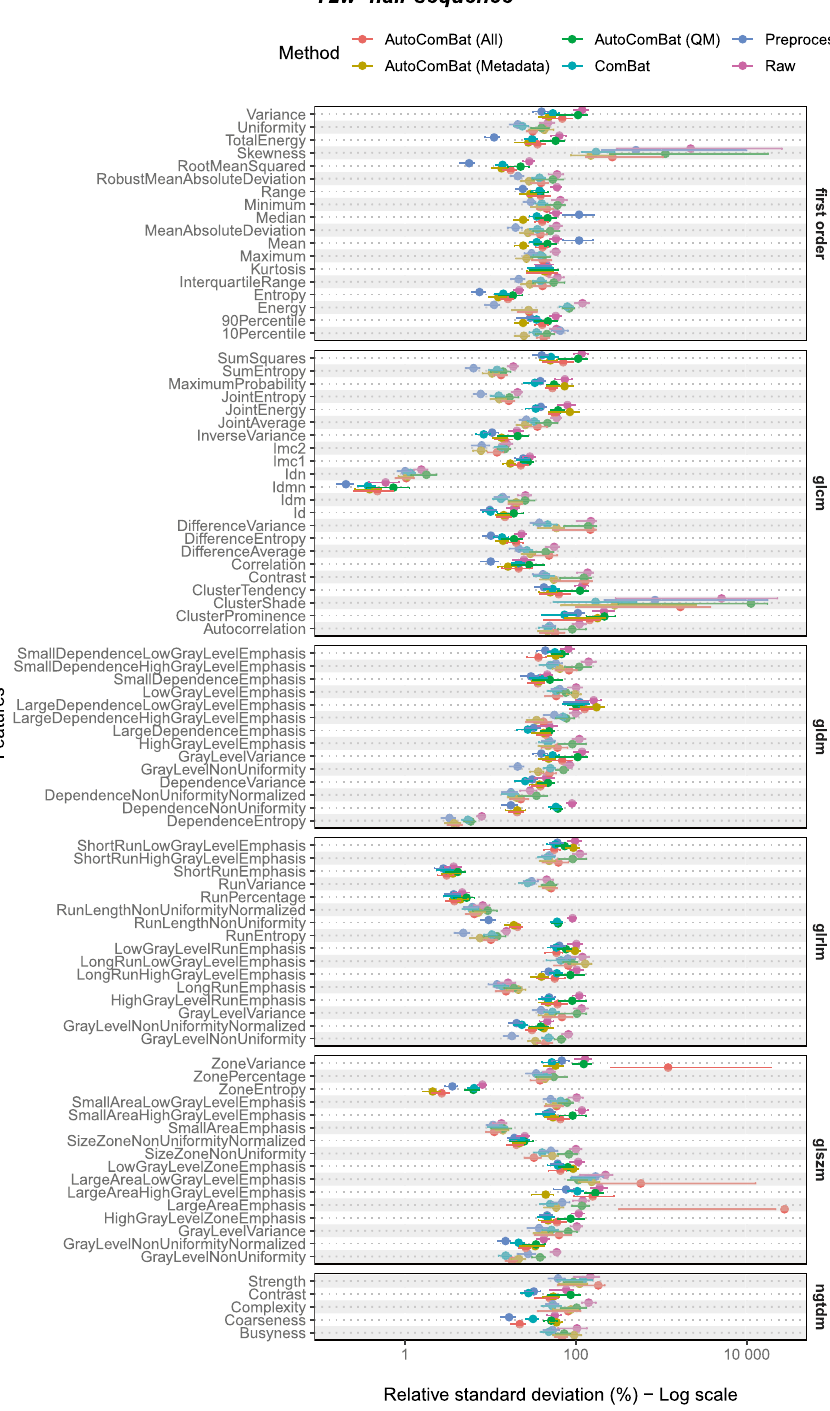
Figure 5. Harmonization strength evaluated on the WM radiomic features for the T2w-flair MRI on the test set. Points represent the RSD values and error bars are the 95%